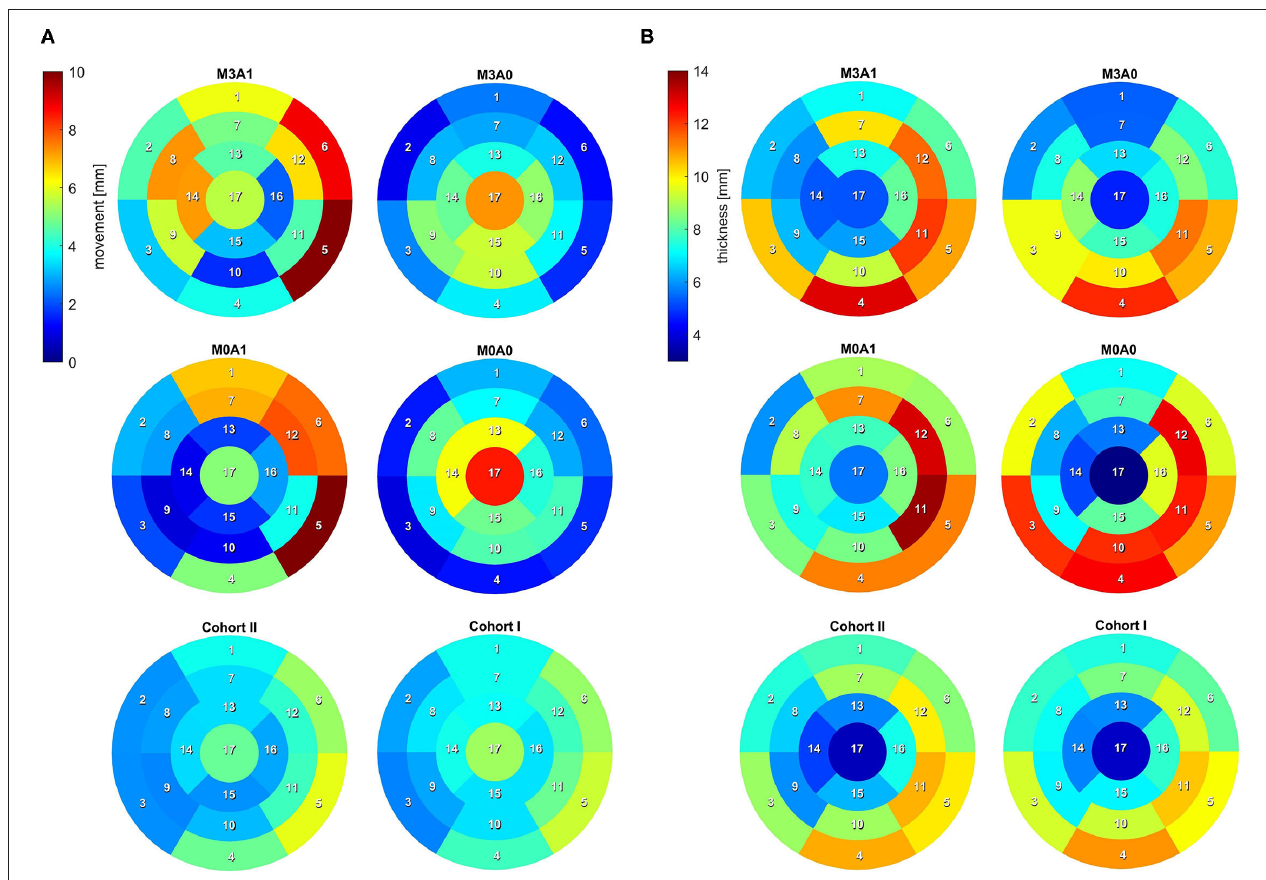
FIGURE 2 | 17-segment representation of (A) the myocardial wall movement (averaged wall distance from LVEDV to LVESV per segment) and (B) the myocardial wall thickness (segmented for the LVEDV). Data are shown averaged for Cohort I and II as well as for the four representative